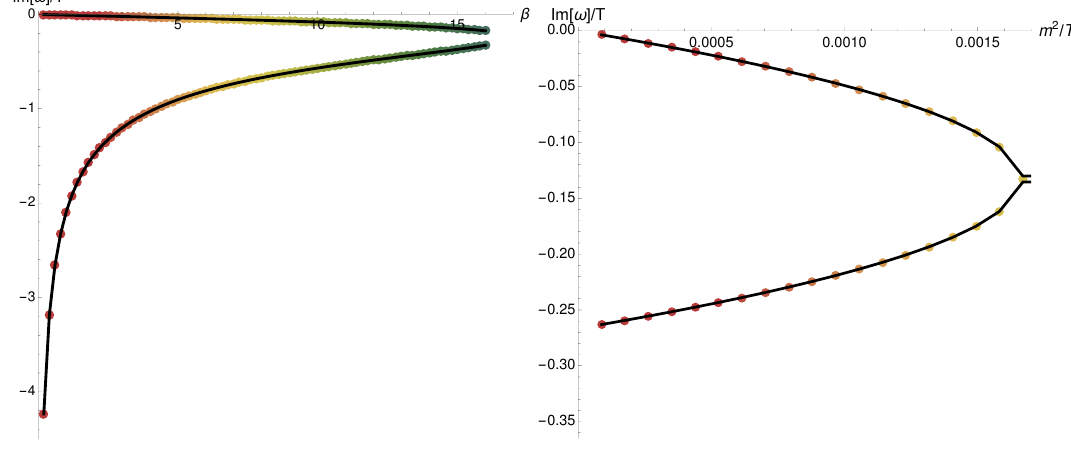
Figure 13 . Fits (black lines) compared to data (colored dots) corresponding to the (cid:12)ts, shown in (cid:12)gures 14 and 15, for data plotted in (cid:12)gure